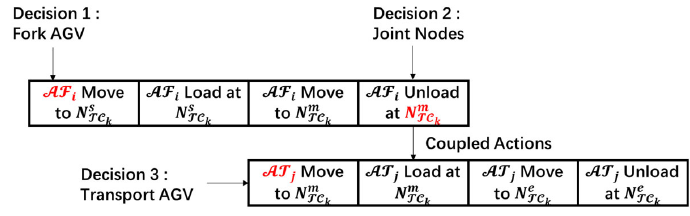
Fig. 5. The decision points of a material transportation task